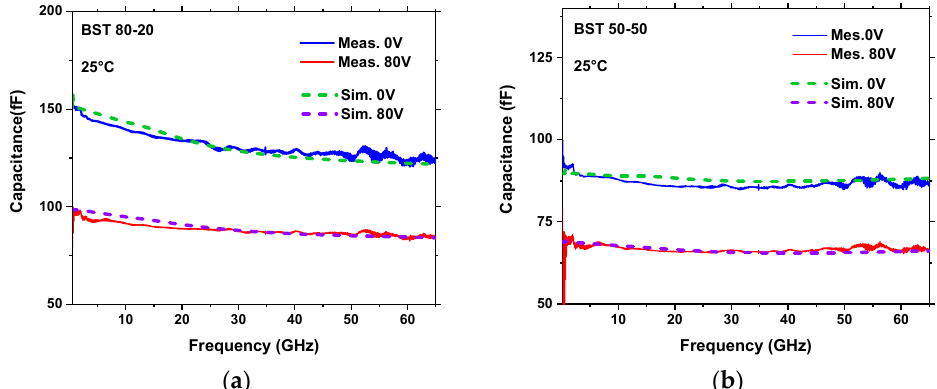
Figure 6. Comparison of measured and full-wave simulated IDC capacitance values versus frequency, for DC bias voltages of 0 V and 80 V, for the two BST compositions BST 80–20 ( a ) and BST 50–50 ( b ).